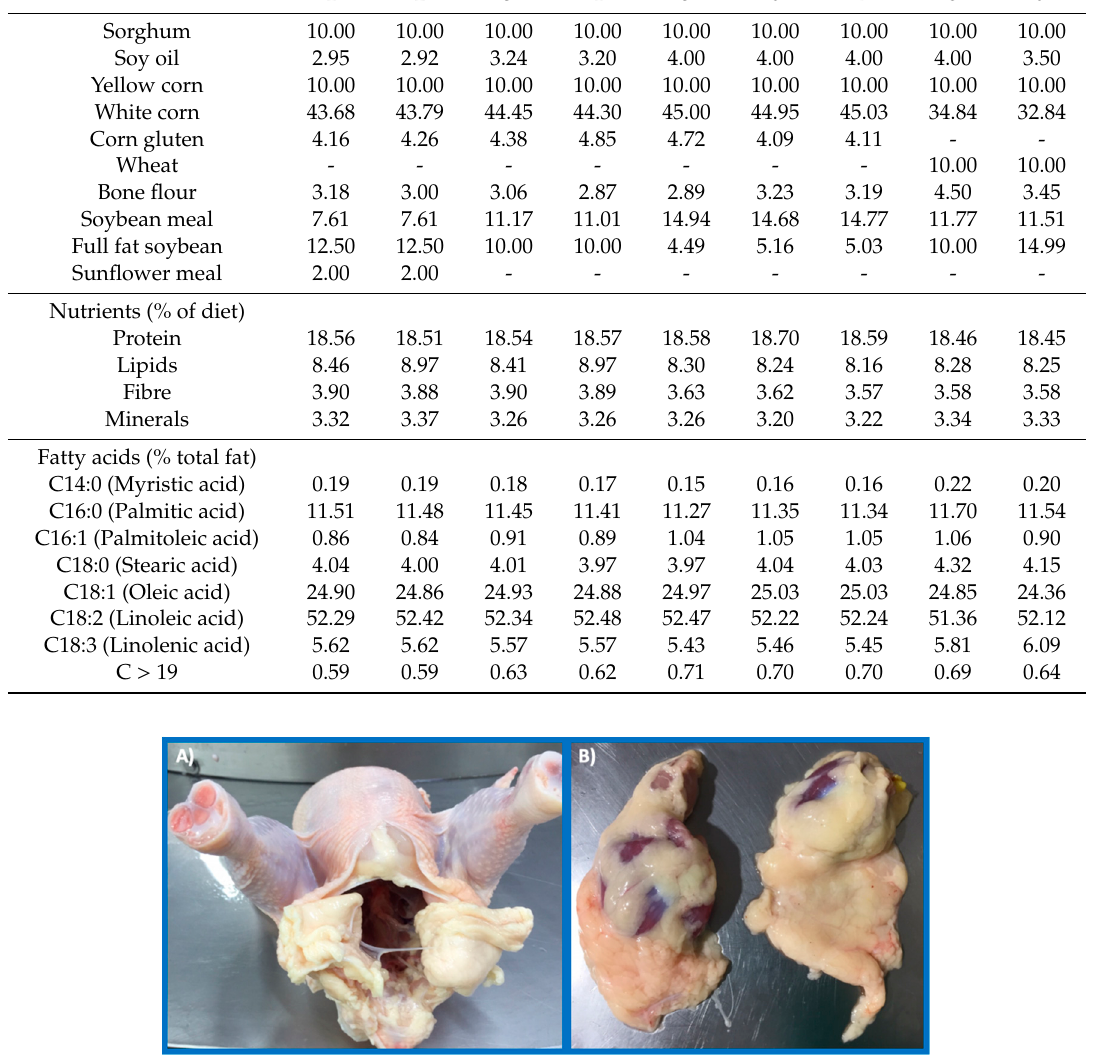
Figure 1. Chicken fat by-products: ( A ) Abdominal fat, ( B ) gizzard fat.